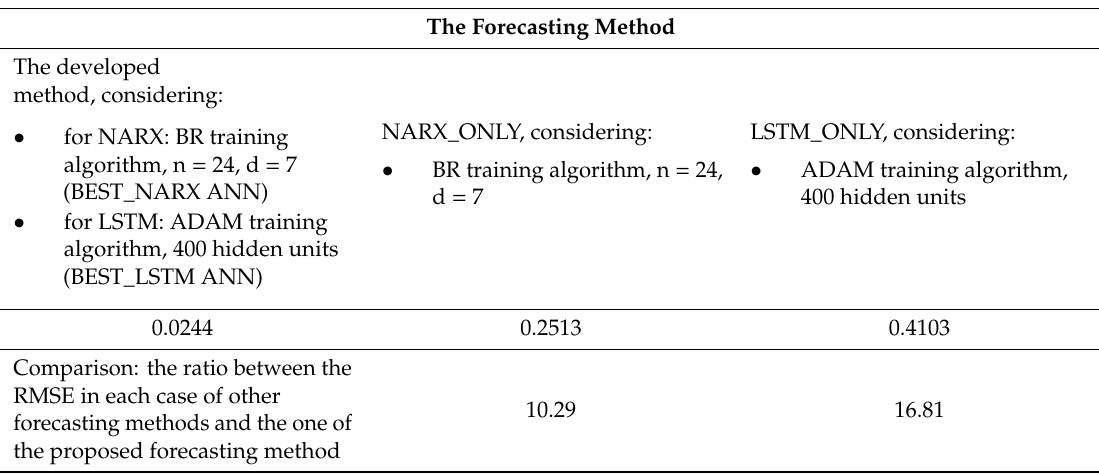
Table 3. The synthesis of the experimental results registered for the developed forecasting method and for the separate NARX and LSTM ANNs. The Values of The Root Mean Square Error and Their Comparison The Forecasting